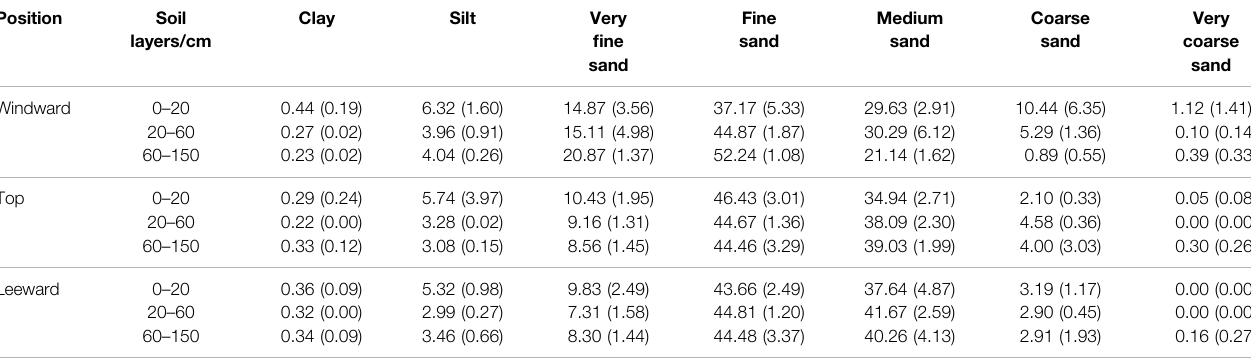
TABLE 1 | Soil particle size (%) of different soil layers. Position Soil layers/cm